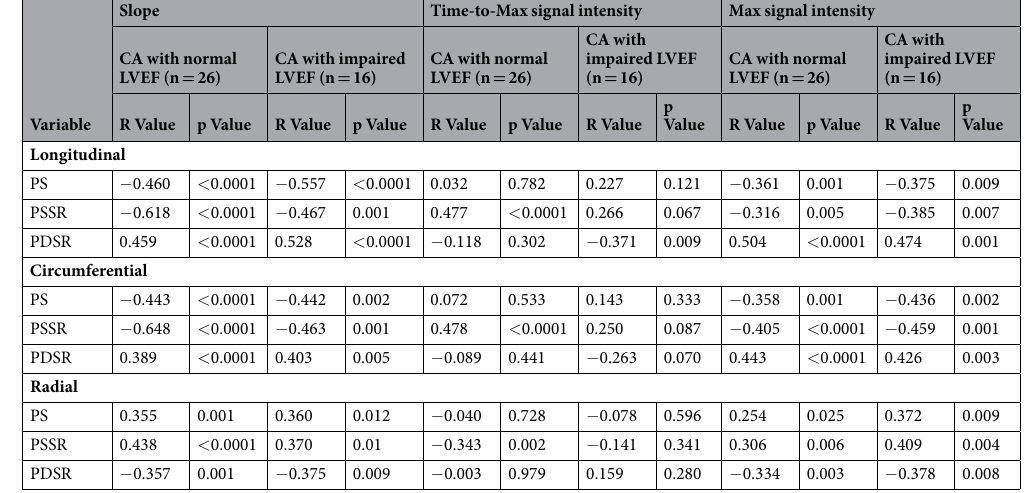
Table 5. Univariable correlations between cardiac deformation parameters and first by-pass parameters in AL-CA subjects with or without LV systolic dysfunction. Note: PS = Peak Strain; PSSR = Peak Systolic Strain Rate; PDR = Peak Diastolic Strain